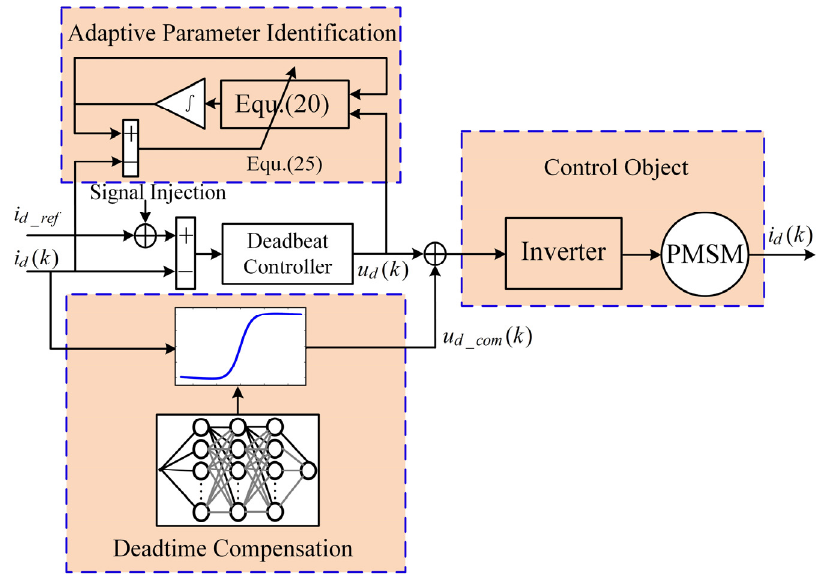
Figure 6. Control structure.